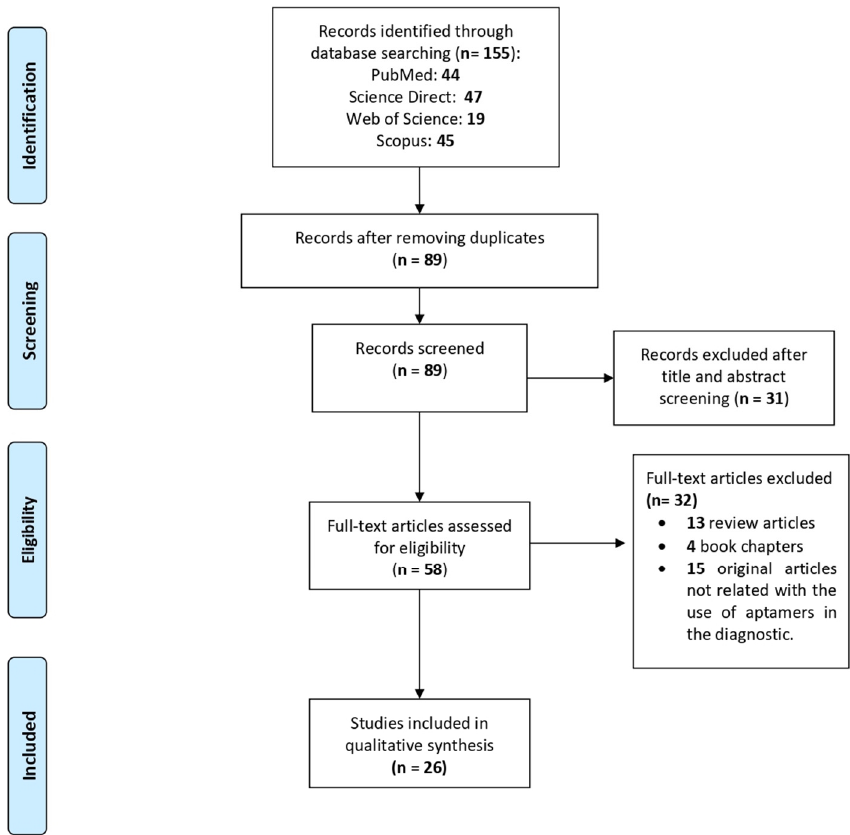
Figure 1. Preferred Reporting Items for Systematic Reviews and Meta-Analyses (PRISMA) flow diagram for article selection included in this systematic review.